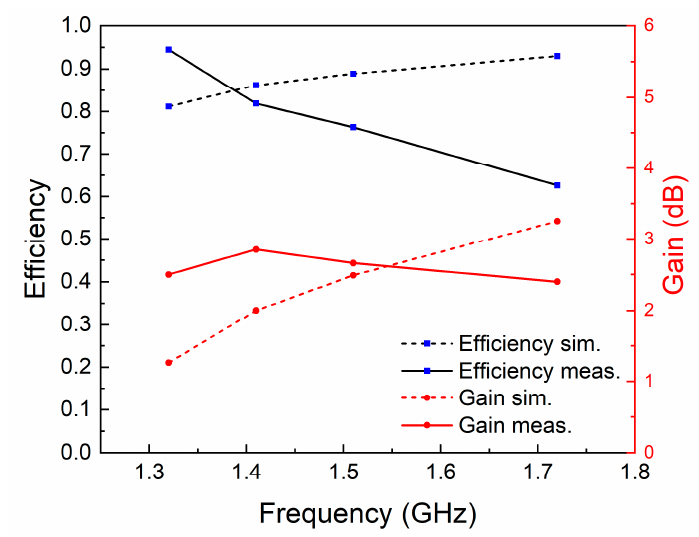
Figure 8. The radiation efficiencies and gains at different resonant frequencies.